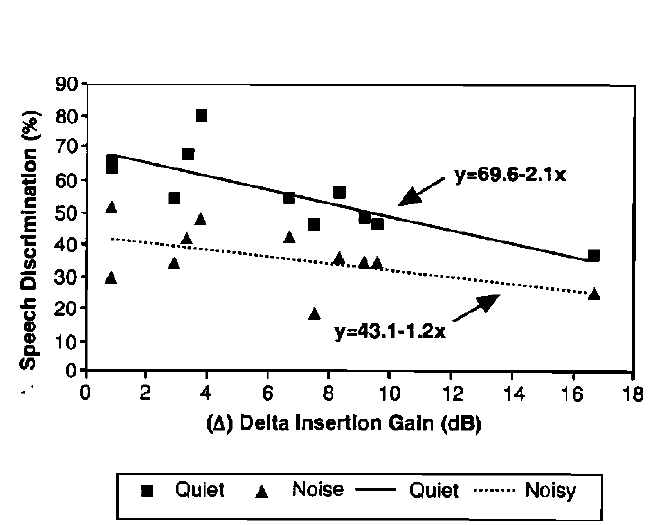
Figure 2. Linear regression of word recognition scores versus Delta functional